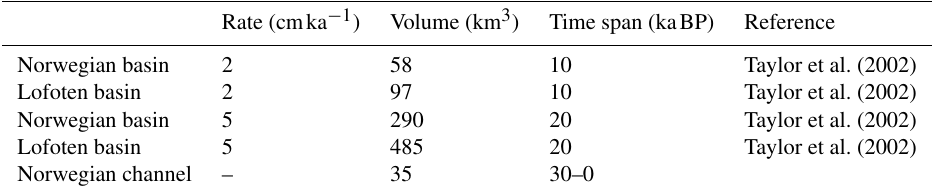
Table A3. Estimates for the volume of sediment displaced in the Lofoten and Norwegian basins and channel